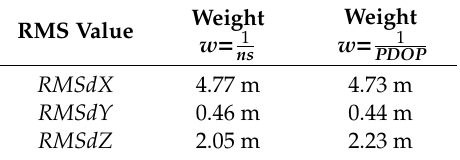
Table 1. The achieved results of the RMS error for tested measurement weights.